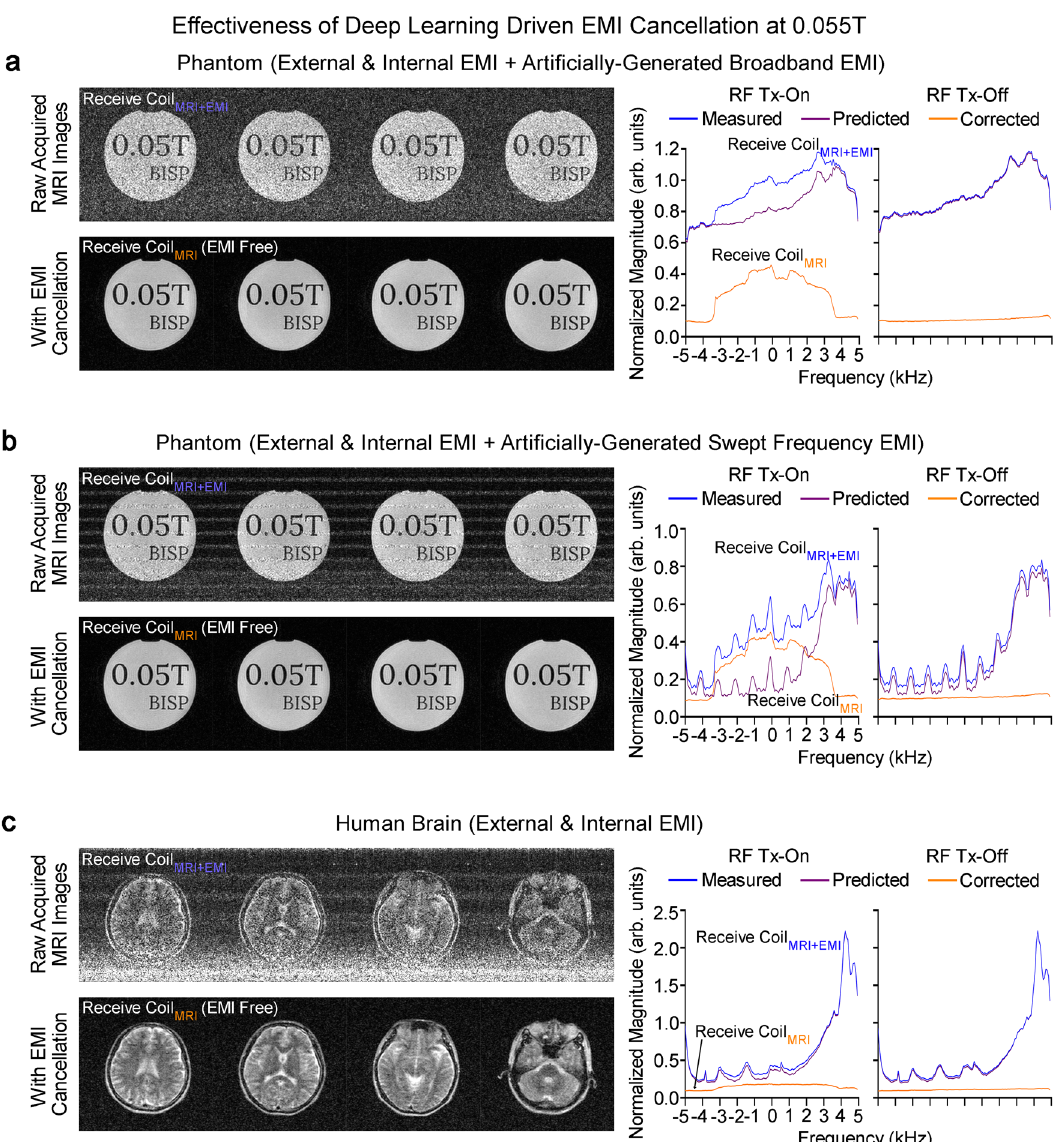
Fig. 3 Robust deep learning driven EMI cancellation for 0.055 T phantom and brain imaging without RF shielding in the presence of various external or internal EMI sources. Representative 3D FSE T2-weighted (T2W) images (left) and corresponding magnitude averaged spectra (right) of raw MRI FE lines, before and after EMI elimination, with RF transmit (Tx) power on (i.e., producing MRI signals) or off (i.e., no MRI signal, EMI signals only) for a phantom with a broadband EMI generated from a nearby source, b phantom with a swept frequency EMI generated from a nearby source, and c human brain (23 yrs. old; male). The proposed deep learning EMI elimination technique can robustly predict the EMI signals detected by the MRI receive coil, enabling MRI scan without any RF cage or shield. Note that, during brain scanning, the large human body acts as an antenna that receives high level of external environmental EMI signals, which can still be effectively eliminated by the